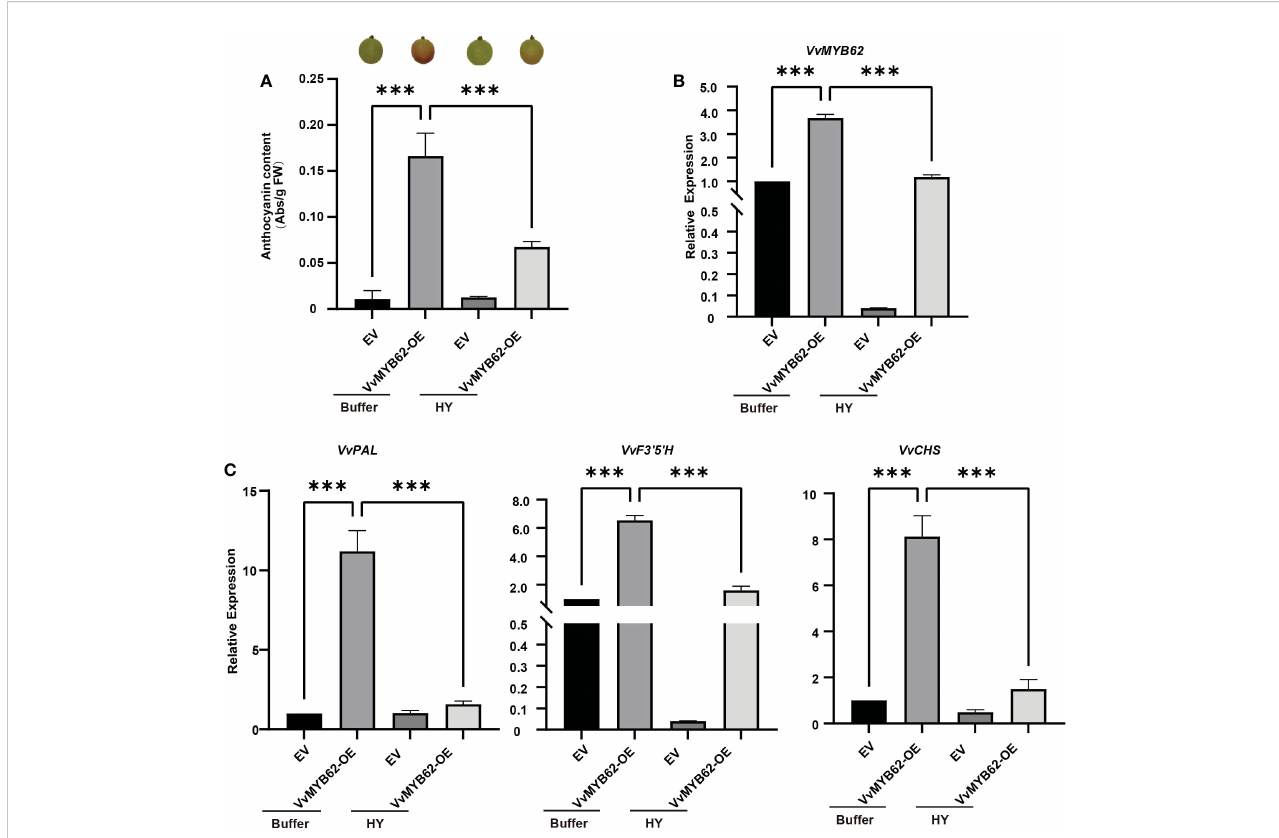
FIGURE 8 The instantaneous transformation of grape fruits. (A) The anthocyanin concentration and phenotypic diagram of grapes following transient overexpression. (B) RT-qPCR was used to identify the relative expression of VvMYB62 in the four treatments after transformation. (C) RT-qPCR was used to identify the relative expression levels of VvPAL, VvCHS , and VvF3 ’ 5 ’ H in the four treatments after transformation. The mean and standard deviation of three independent biological replicates are used to express values. Signi fi cant statistically: **0.05<P<0.01; ***P< 0.01.